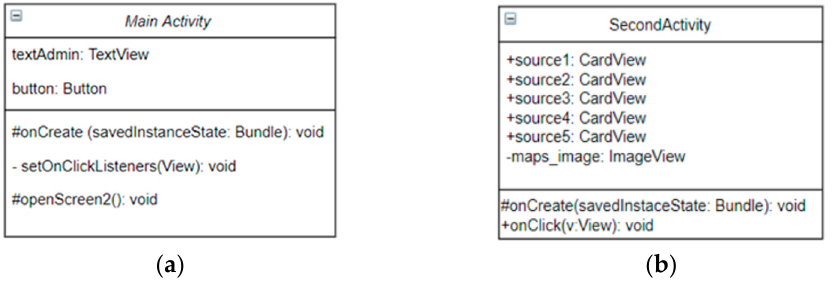
Figure 6. ( a ) Class diagram of main activity of the mobile application; ( b ) class diagram of the second activity of the water status app.